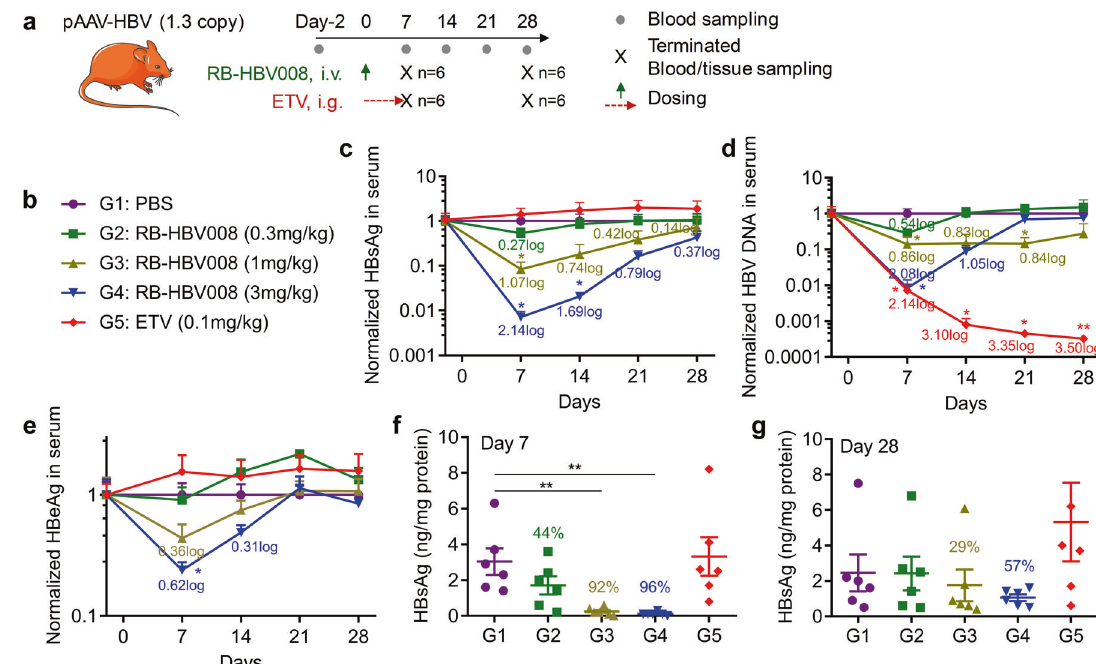
Fig. 5 Ef fi cacy of RB-HBV008 in pAAV-HBV mouse model. a Treatment and sampling schedule of the study. b Grouping information. c – e Levels of HBsAg ( c ), viral DNA ( d ), and HBeAg ( e ) in circulation during the treatment course. f , g Expressions of HBsAg in the liver tissue were examined on day 7 ( f ) and day 28 ( g ). Data were shown as mean ± SEM. * P < 0.05, ** P < 0.01 (two-tailed t